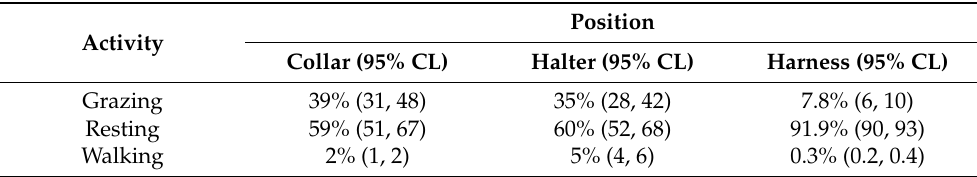
Table 7. The mean (95% confidence limits, CL) daily time spent grazing, resting, and walking for three days recorded continuously by tri-axial accelerometers positioned on a neck collar, head halter and body harness of ewe lambs ( n = 10).